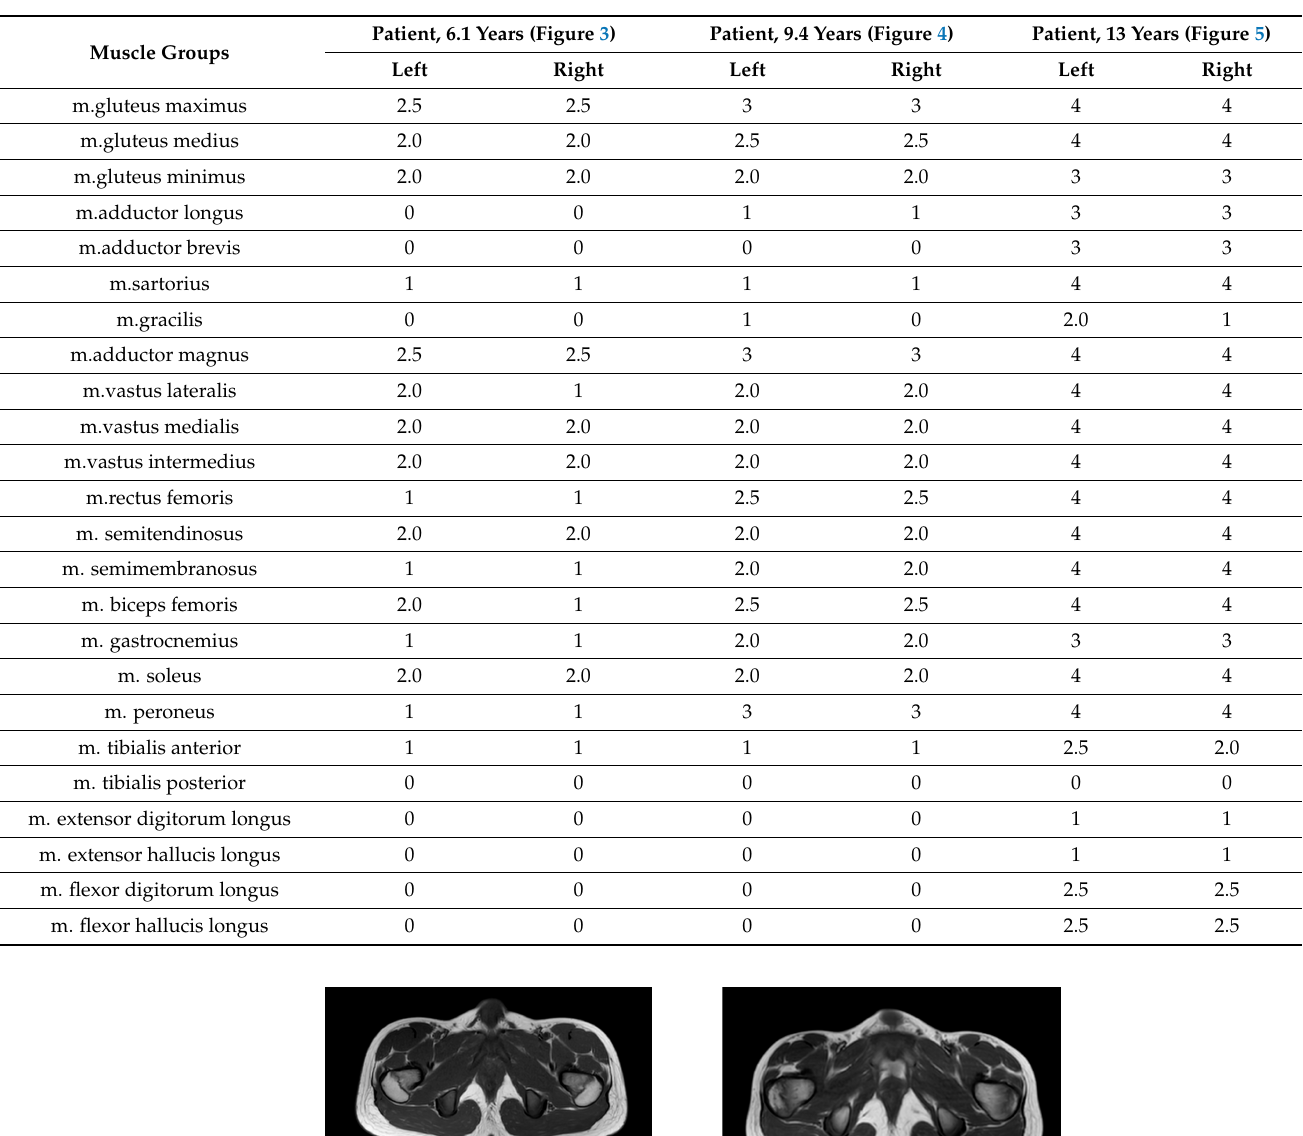
Table 6. Evaluation of the severity of fibro-fatty muscle degeneration according to the Mercuri scale (point) of patients in accordance with clinical examples Figures 3–5.